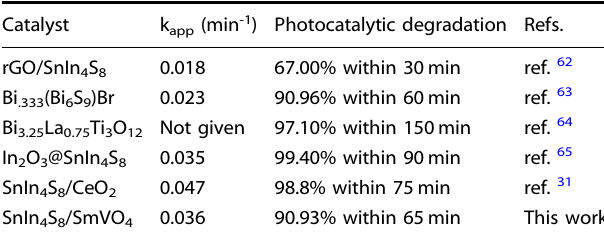
Table 2. Photocatalytic Cr 6 + reduction over various photocatalysts under visible light irradiation.